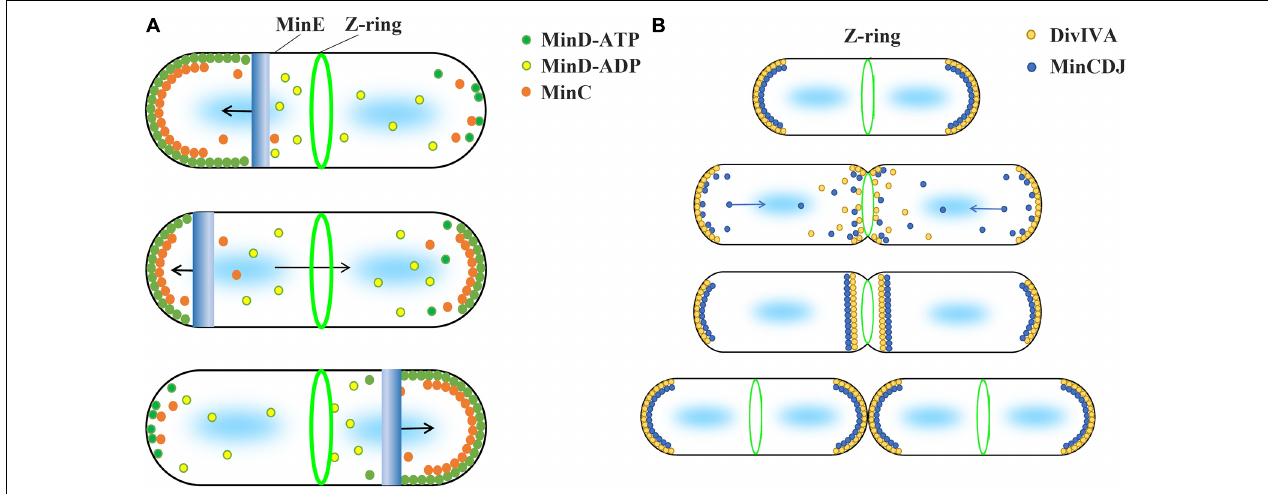
FIGURE 1 | Current model suggests that the concentration gradient of MinC in cell regulates the Z-ring position. The two types of Min system use different strategies to form protein concentration gradients. (A) The Min system of Gram-negative bacteria, such as E. coli and P. aeruginosa , consists of MinC, MinD, and MinE proteins and is known as the MinCDE system. The MinD-ATP dimer (green) preferentially binds to the membrane, while the MinD-ADP subunits (yellow) detach from the membrane. MinE (blue) can stimulate the ATPase activity of MinD and release MinD and MinE from the membrane. This makes MinE drive the oscillation of MinD from one end of the cell to the other, which leads to an apparent concentration gradient of MinD in the cell, with the average concentration being lowest in the middle of the cell and highest near the poles. MinC (orange), as an FtsZ inhibitor, binds to MinD and moves with the movement of MinD. High concentration of MinC inhibits FtsZ polymerization, which is used by current models to explain how the Min system regulates the positioning of Z-ring. (B) Gram-positive bacteria, such as B. subtilis , contain MinC, MinD, MinJ, and DivIVA proteins known as the MinCDJ system. Min proteins (blue) concentration gradient is regulated by DivIVA (orange), which favors attaching to the negative curvature membrane. When DivIVA is mainly bound at both ends of the cell, MinD exhibits a stationary bipolar gradient pattern. This is easily explained by current models. However, DivIVA proteins will relocalize at midcell as soon as the membrane invagination begins, and MinCDJ proteins localize to division sites and poles at the same time in dividing cells. It cannot be explained by the existing model that high concentration MinC inhibits the assembly of Z-ring. A revised model suggested that MinCDJ moved to the middle of the cell to prevent a new round of division and/or might act on some downstream proteins of Z-ring